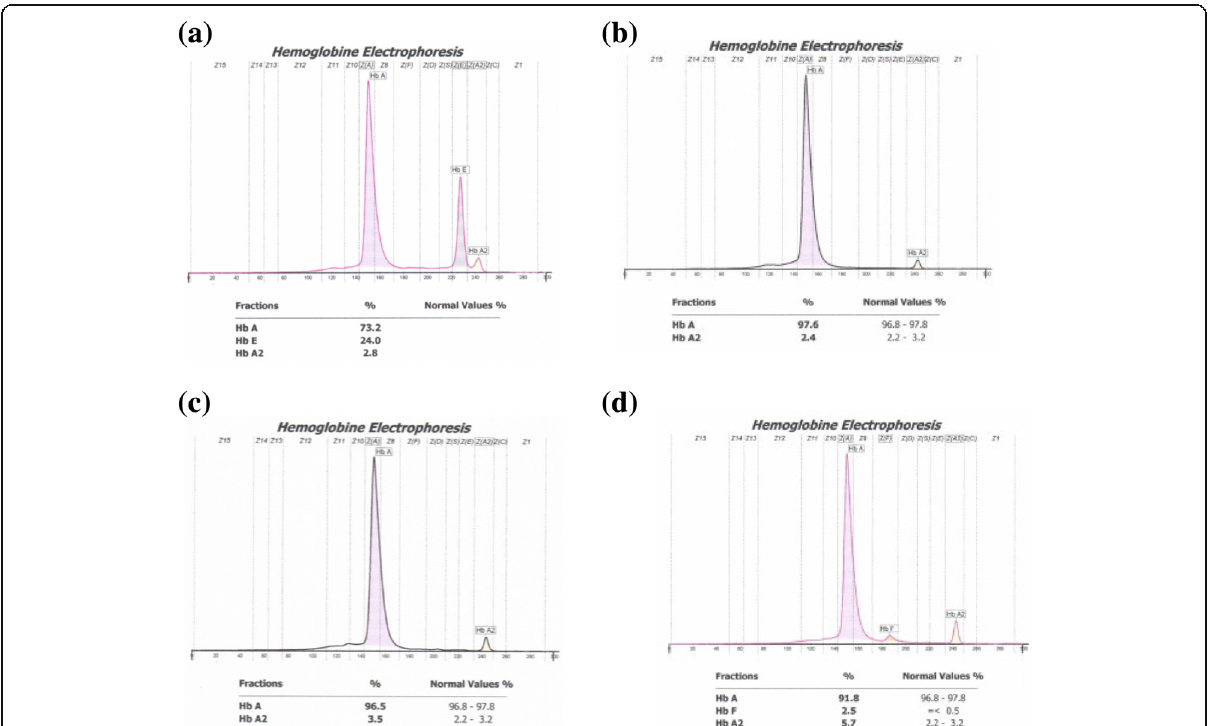
Fig. 1 Peaks of various Hb fractions (HbA, HbA2, HbF, and HbE) by capillary electrophoresis. HbE is clearly shown next to HbA2 ( a ), and all samples have mutations at c.79G>A (CD26). HbA2 is normal (2.2 – 3.2%) and borderline (3.2 – 3.9%), as shown in ( b ) and ( c ), respectively. HbA2 is high (>4%) ( d ), and most samples have mutations at c92+5G>C